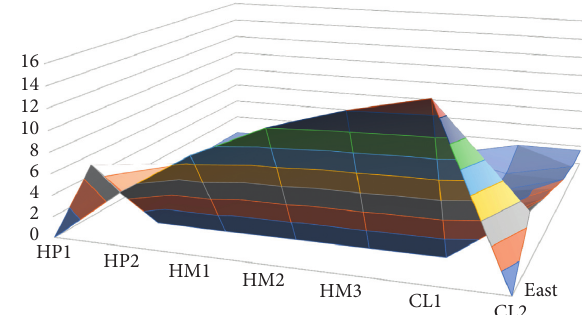
Figure 9: The influence of students’ attitude on the decision tree